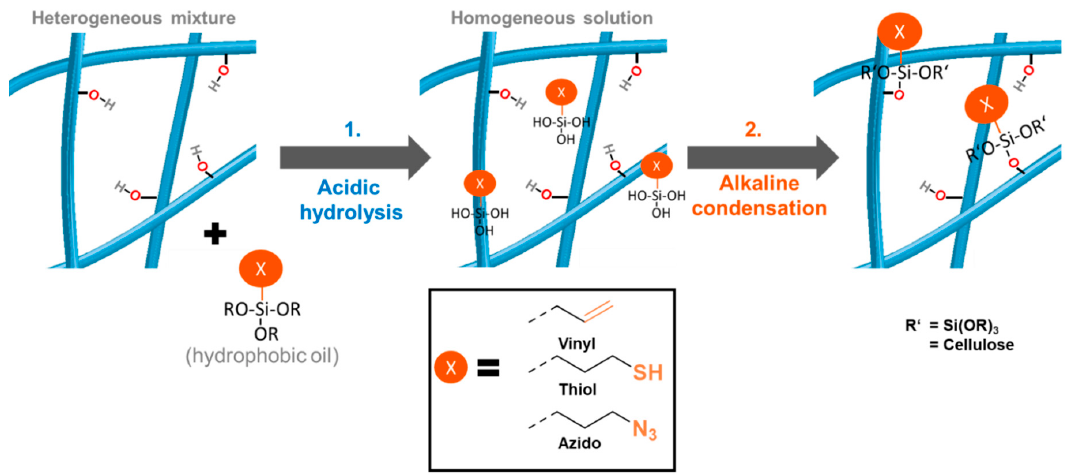
Figure 2. Novel two-step silanization protocol: First, the reaction mixture is acidified with dilute HCl (catalytic) to induce hydrolysis of the alkoxysilane, then dilute NaOH (catalytic) is added to induce condensation with the cellulose surface. Following this protocol, azide, vinyl and thiol functions were introduced.